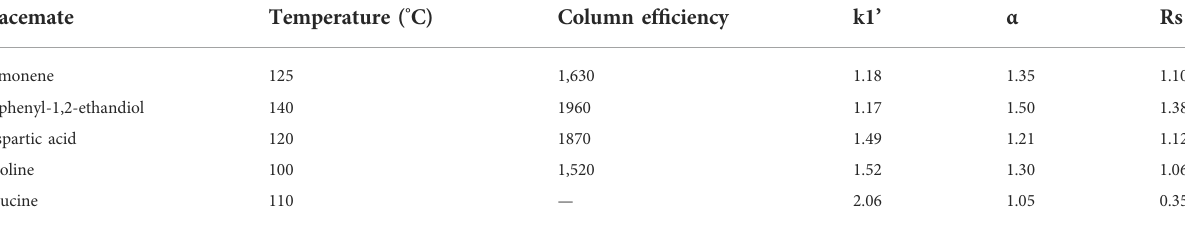
TABLE 4 Different racemates separation on capillary column coated with MOF. Reproduced with permission from (Xie et al., 2014).